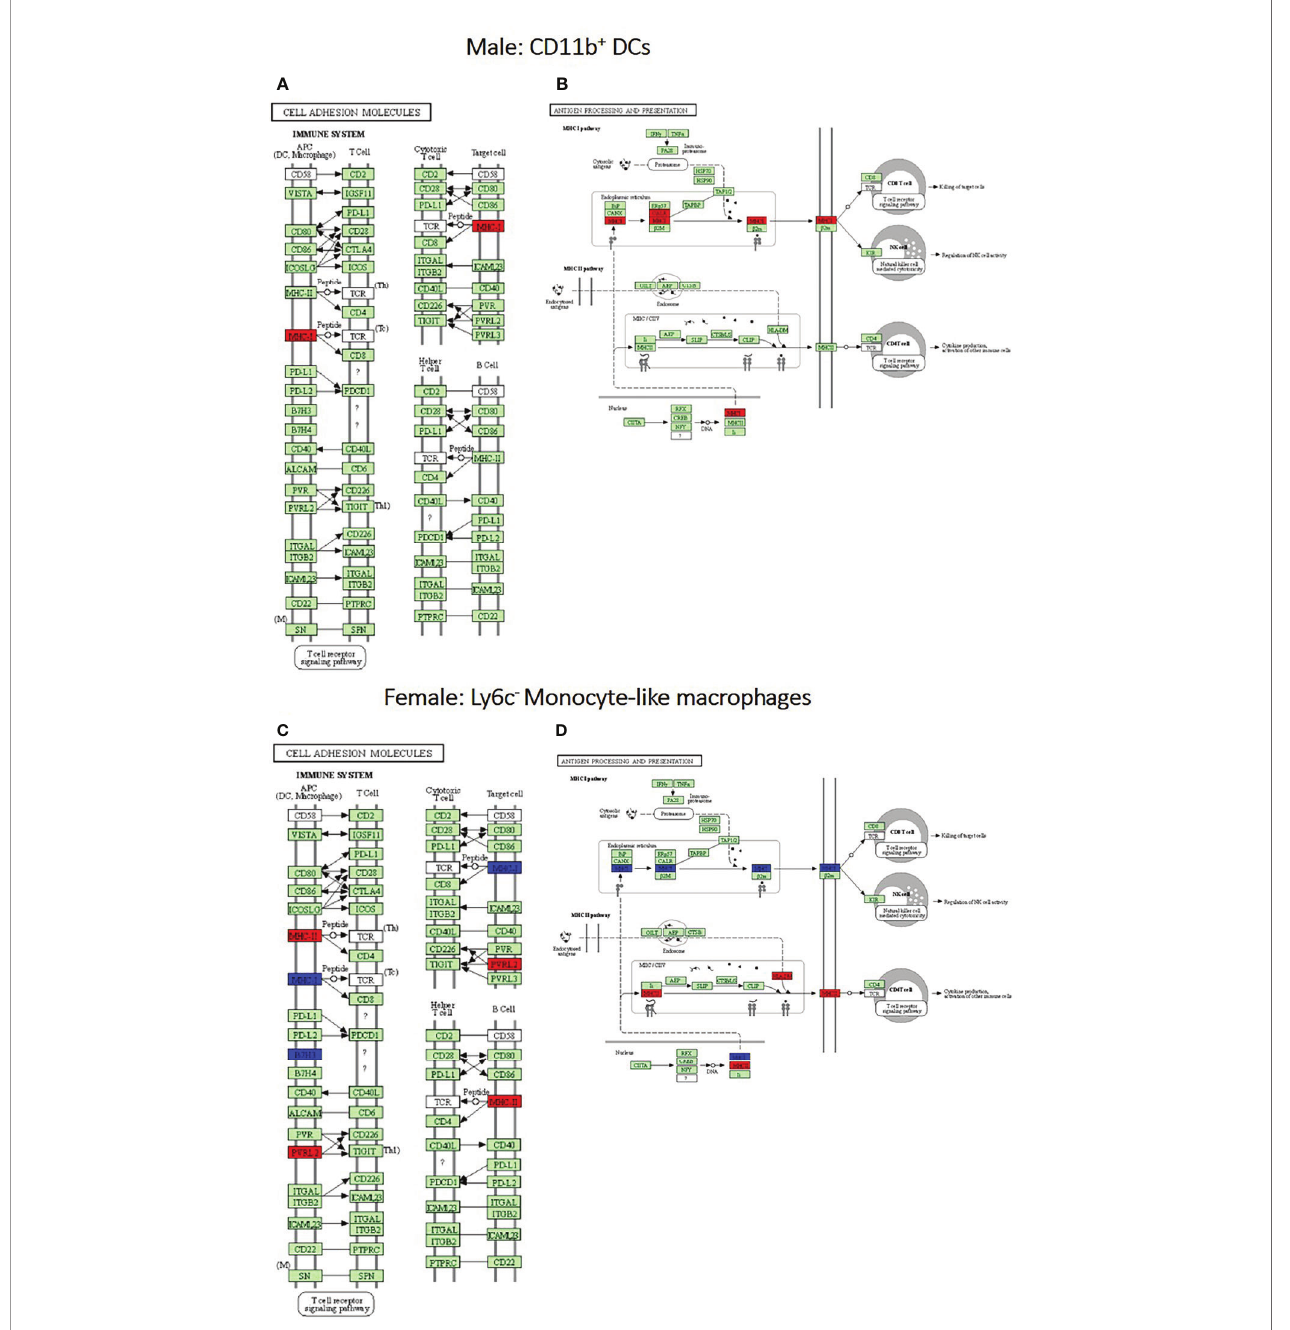
FIGURE 6 | Permissive and non-permissive (antifungal) pulmonary phagocytes exhibit transcriptional differences in immune associated pathways. Using male and female BALB/c mice, phagocyte subsets were puri fi ed and incubated with C. neoformans strain H99 at 37°C, 5% CO 2 for 2hrs at a ratio of 20:1. Following incubation, cells were collected and stored in TriZol at -20°C until analysis. RNA puri fi cation and analysis was conducted by Novogene using SMARTer Stranded V2 library prep and samples were sequenced using the Illumina Platform. Differential expression analysis was compared between each macrophage and DC subset alone and following incubated with C. neoformans strain H99. Signi fi cant differences in gene expression were identi fi ed and grouped into signaling pathways using KEGG Pathway Analysis. (A, B) . Up- and down-regulation of genes associated with male CD11b + dendritic cells (DCs) within the cell adhesion molecules and antigen processing and presentation signaling pathways, respectively. (C, D) . Up- and down-regulation of genes associated with female Ly6c - monocyte-like macrophages within the cell adhesion molecules and antigen processing and presentation signaling pathways, respectively. Blue and red represent genes up- regulated or down-regulated, respectively, in CD11b + DCs and Ly6c - monocyte-like macrophages interacting with C. neoformans compared to the subset alone. Data were generated from a merged data set (n=2) from 2 independent female and 2 independent male mouse